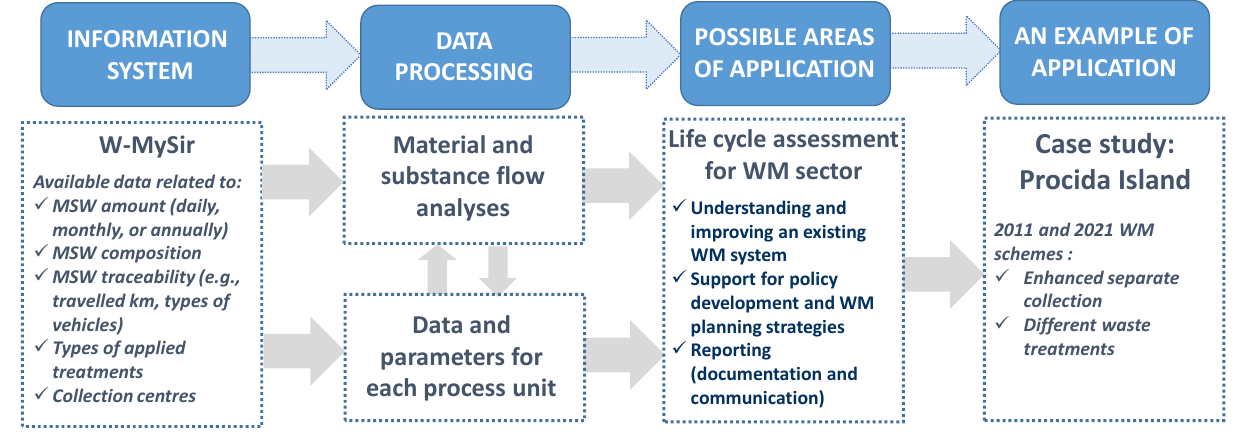
Figure 1. Data flows between the solid waste information system and the proposed LCA study.